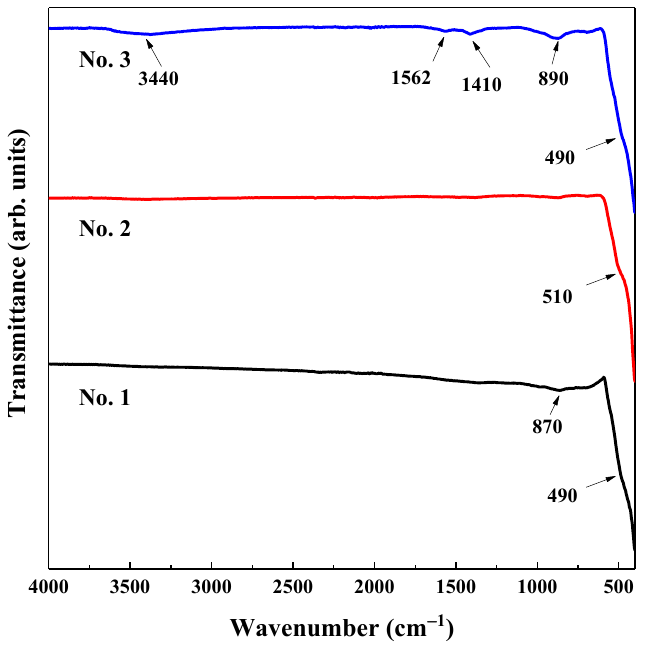
Figure 2. FT-IR spectra of ZnO samples.